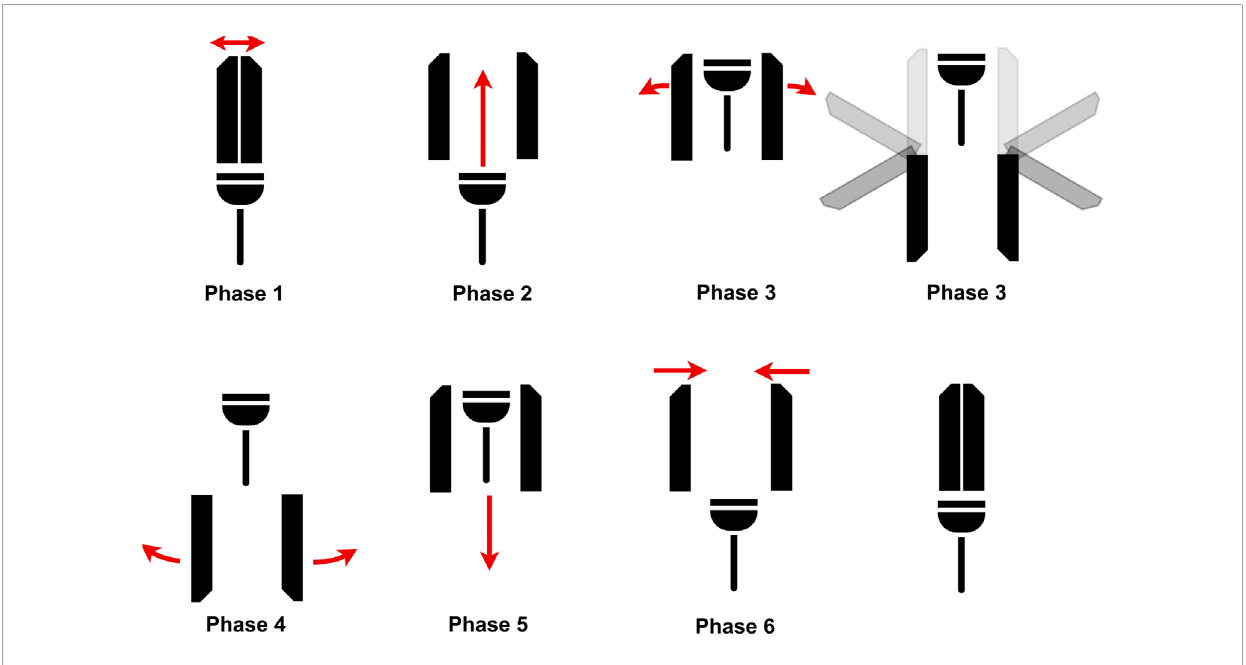
FIGURE 12 Different desired